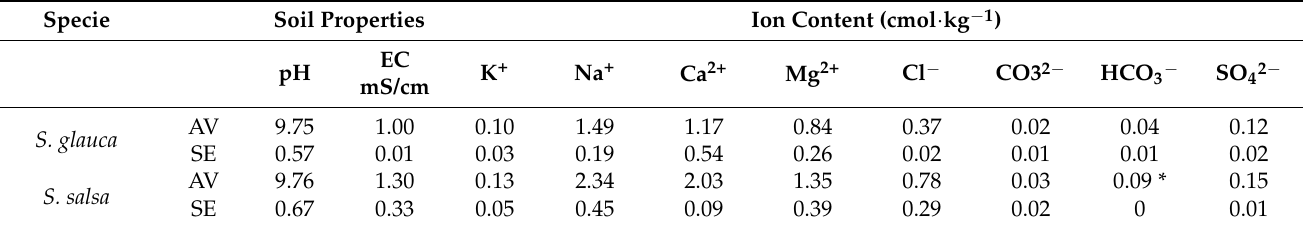
Table 1. The properties and ion contents in the soil surrounding S. glauca and S. salsa in natural habitats. Asterisks indicate significantly different means between communities according to the T test ( p <